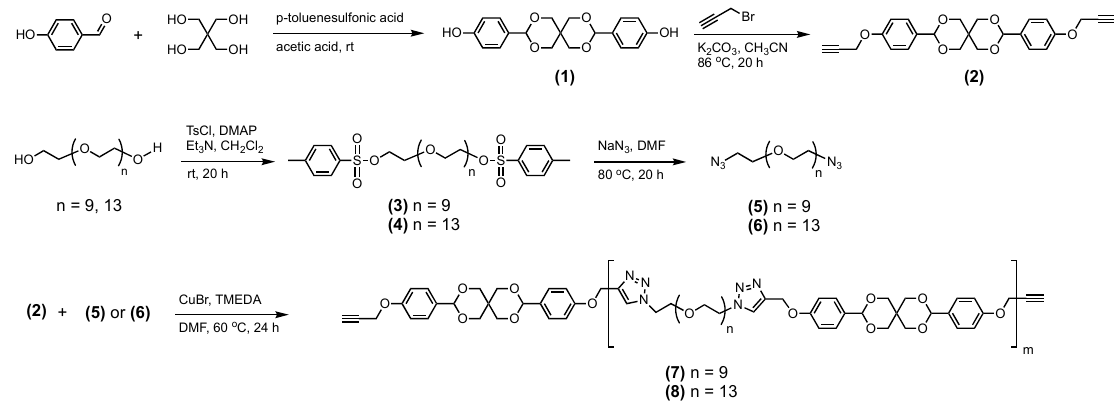
Scheme 2. The synthesis of the monomers and the spirocyclic polyacetals. TsCl: p -toluenesulfonyl chloride.